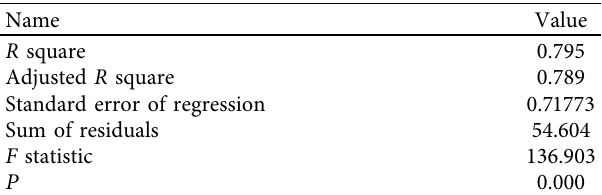
Table 17: Statistics of regression models (mean velocity variation in a certain window width).